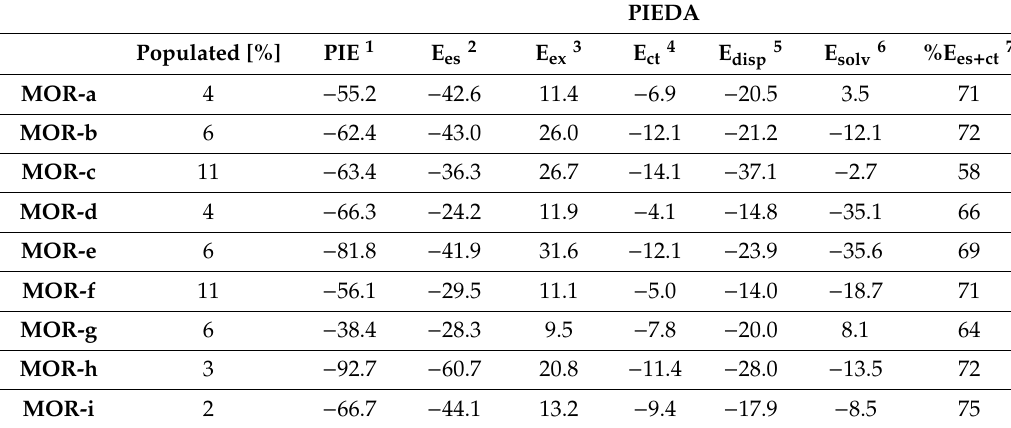
−64.7 kcal/mol (range: −38.4 to −92.7 kcal/mol). In comparison with the opioid part, the polar